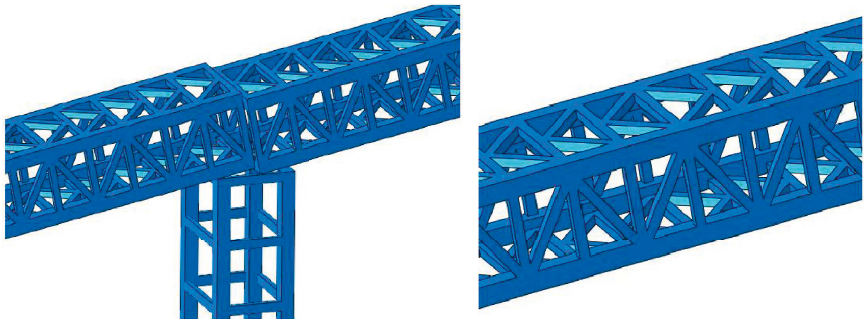
Figure 4: Partial details of the